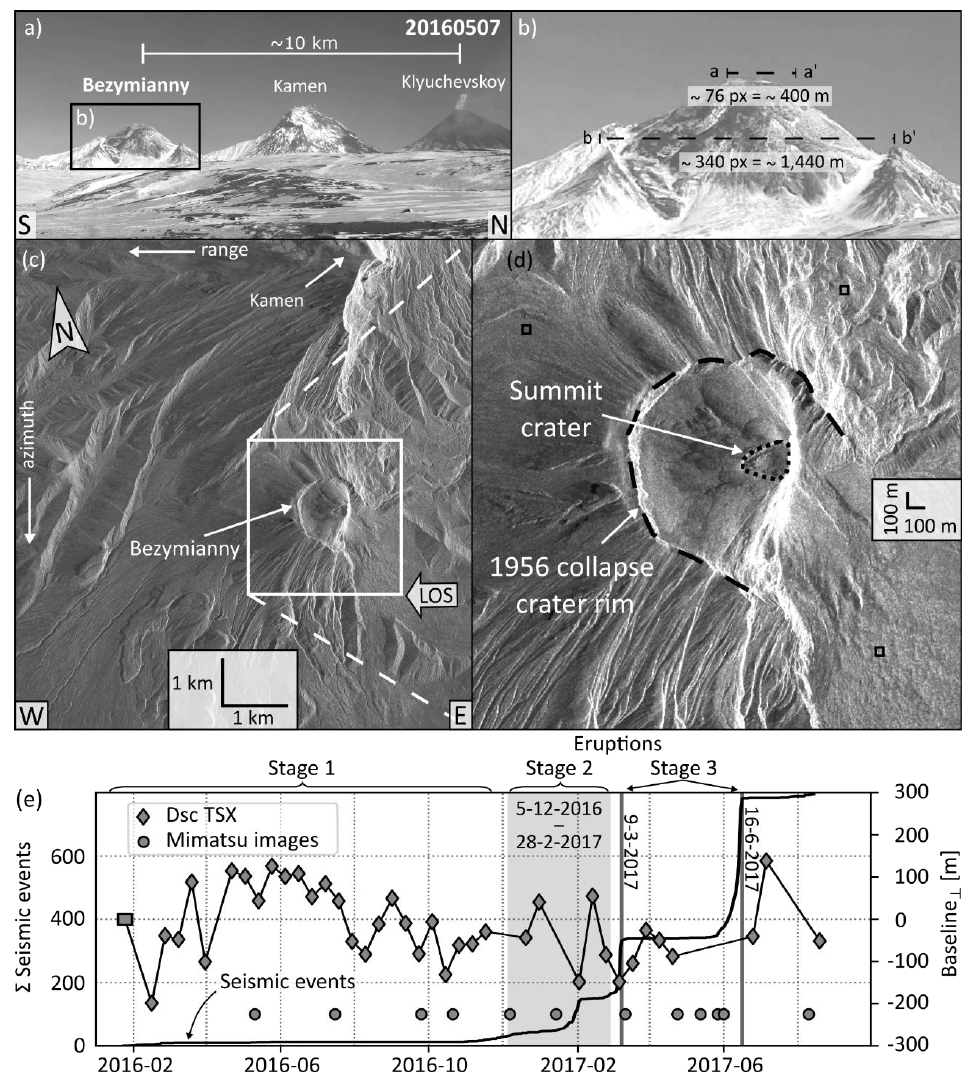
Figure 2. ( a ) Monitoring camera image of Bezymianny and its neighbouring volcanoes on 7 May 2016. View is to the west. Black box denotes image details shown in: ( b ) Close-up view of Bezymianny. Pixel and metric distances between a –a’ and b–b’ are derived from a terrain model (cf. Figure 1b). ( c ) Descending non-geocoded spotlight-mode TSX amplitude image from 23 September 2016 (cf. Figure 1a). Flight direction (azimuth) and line-of-sight (LOS) or range direction of the satellite are indicated. White box shows area used for pixel offset tracking displayed in: ( d ) Close-up of Bezymianny. Small black boxes mark assumed stable areas (i.e., no deformation) referred to later